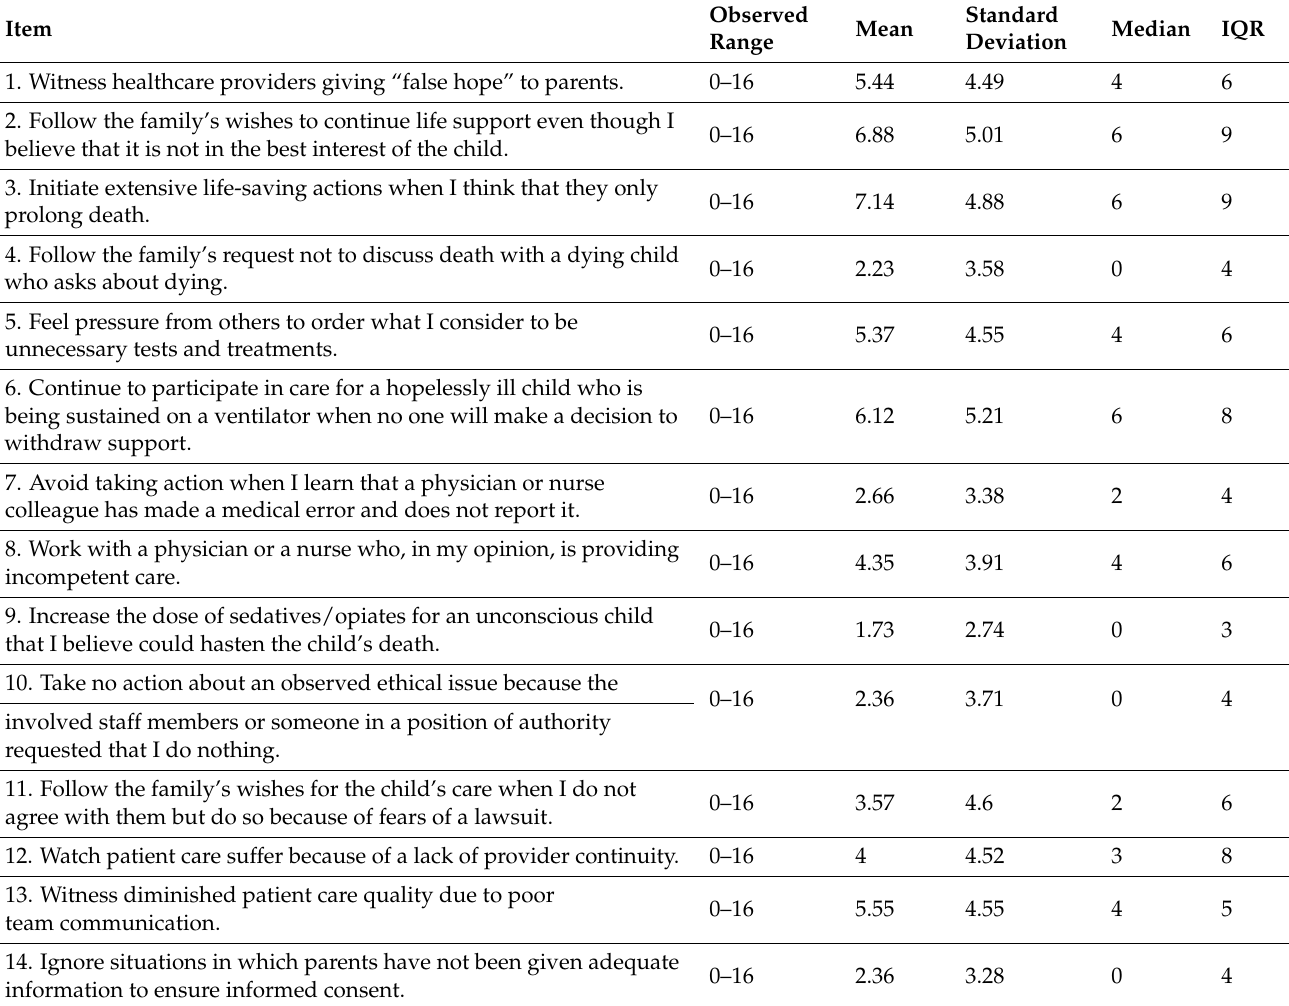
Table 2. Descriptive statistics of the composite scores of the individual items of the Italian Pedi- atric MDS-R